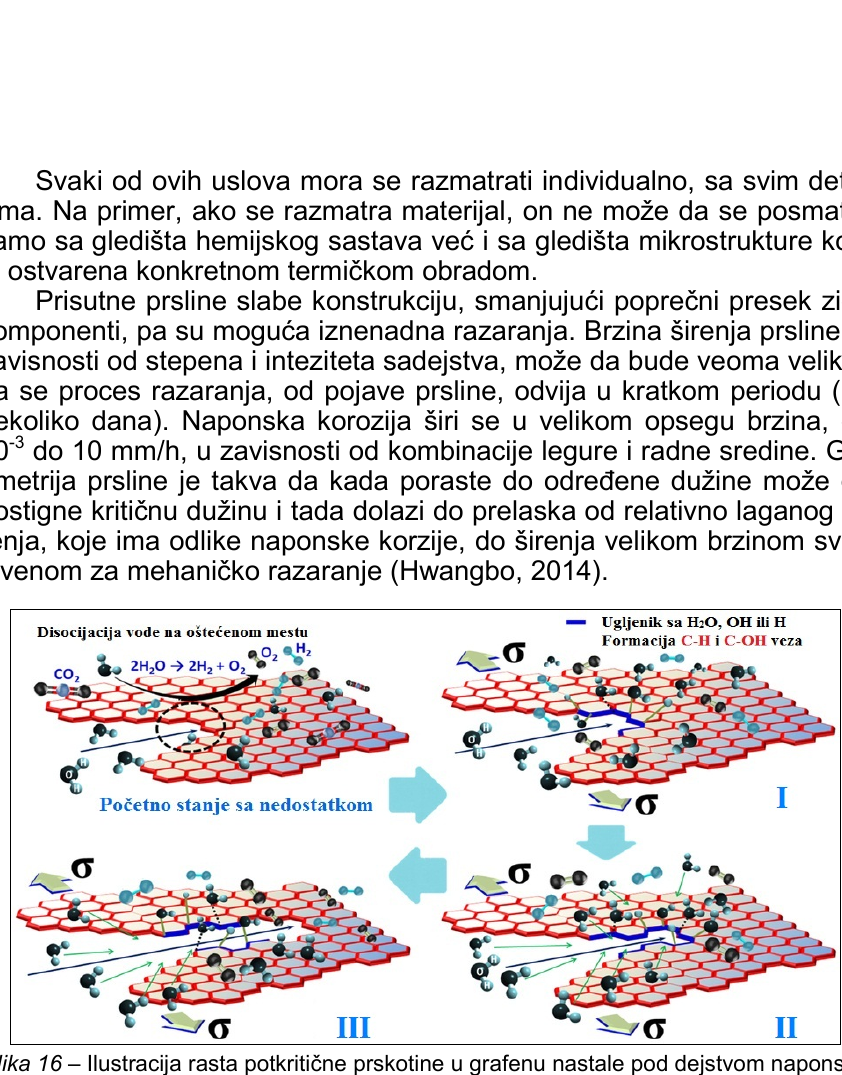
Figure 16 – Illustration of subcritical crack growth in graphene formed under the influence of stress corrosion. I) adsorption of water vapor to carbon bonds in graphene; II) diffusive transport of water vapor to graphene; III) electrostatic interaction between water vapor and